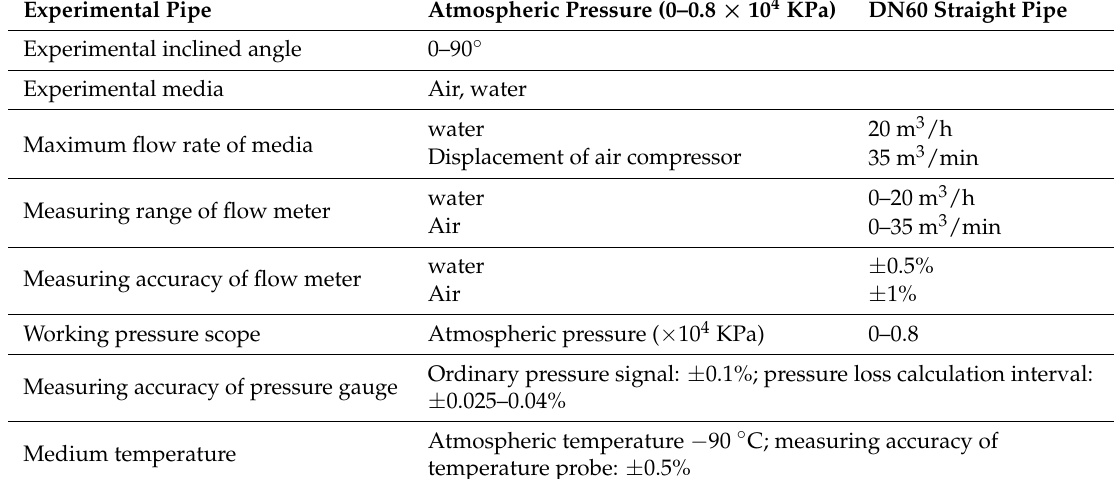
Table 1. Parameters of experimental apparatus.